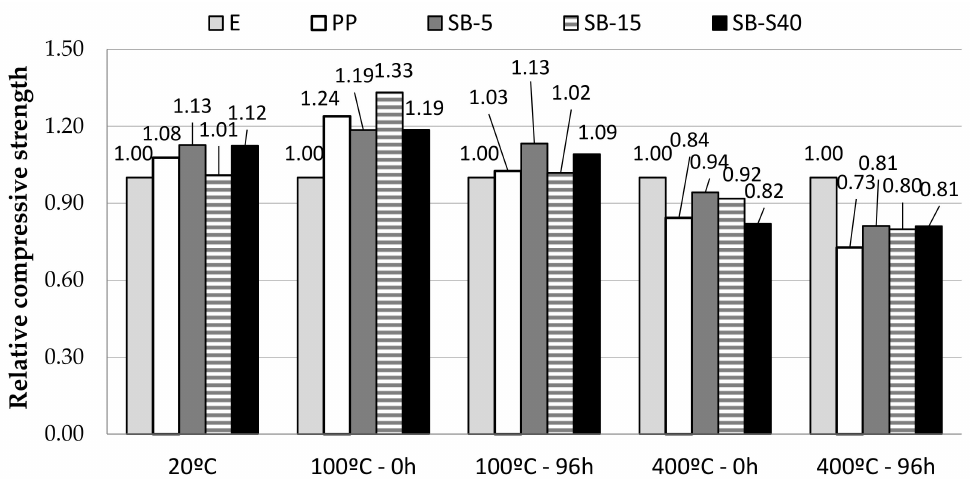
Figure 14. Residual compressive strength of reinforced concrete compared with reference mixture E under the same testing conditions.